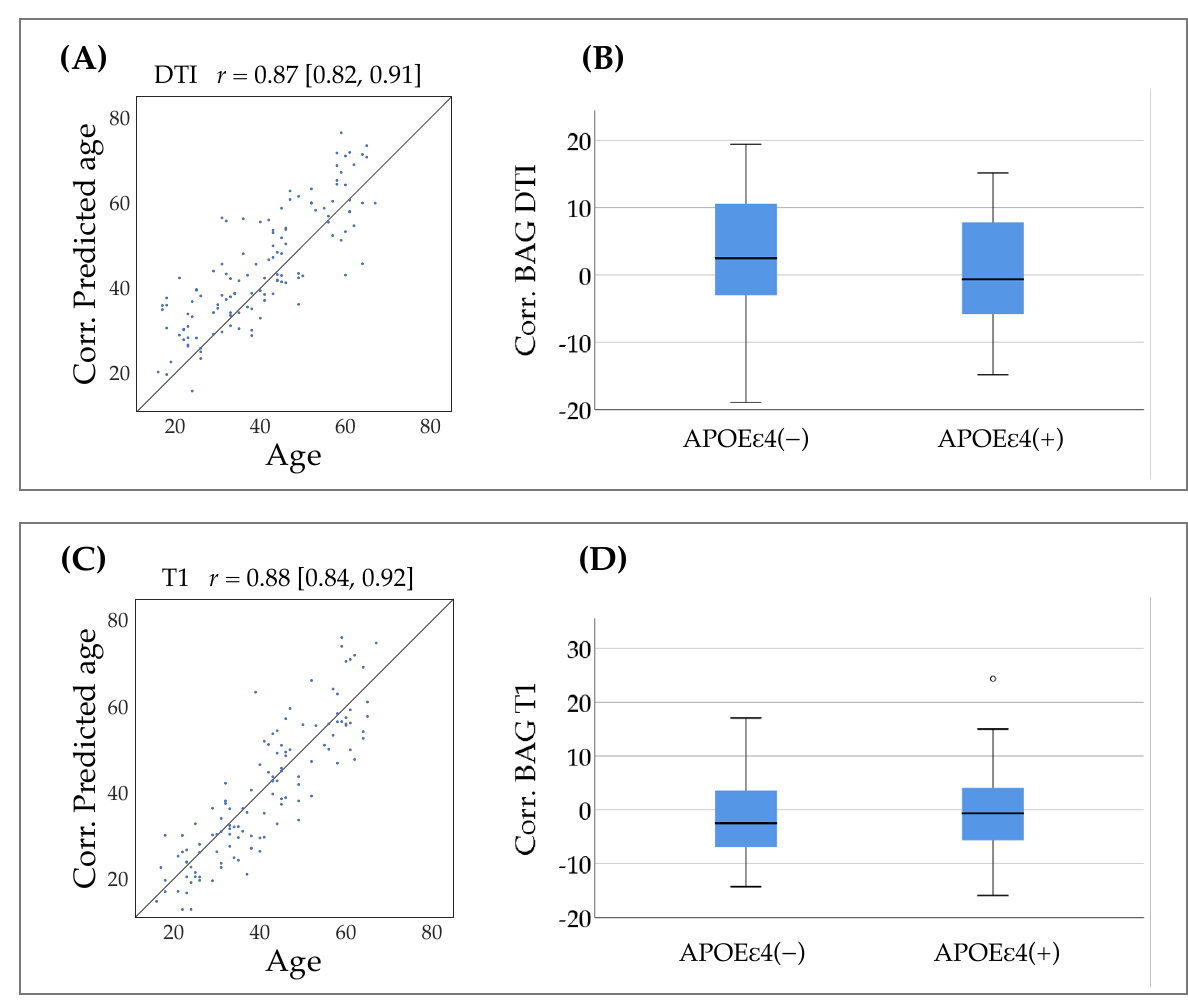
Figure 1. Brain-age prediction and BAG distributions per APOE group. ( A ) Chronoligcal age (x-axis) versus DTI-based corrected predicted age (y-axis; corrected for age-bias as described in Section 2.5). ( B ) The distribution of corrected DTI- based BAG estimated per APOE group (carriers versus non-carriers). ( C ) Chronological age (x-axis) versus T1-based corrected predicted age (y-axis). ( D ) The distribution of corrected T1-based BAG estimates per APOE group (carriers versus non-carriers). Abbreviations: Corr. = corrected, BAG = Brain-age